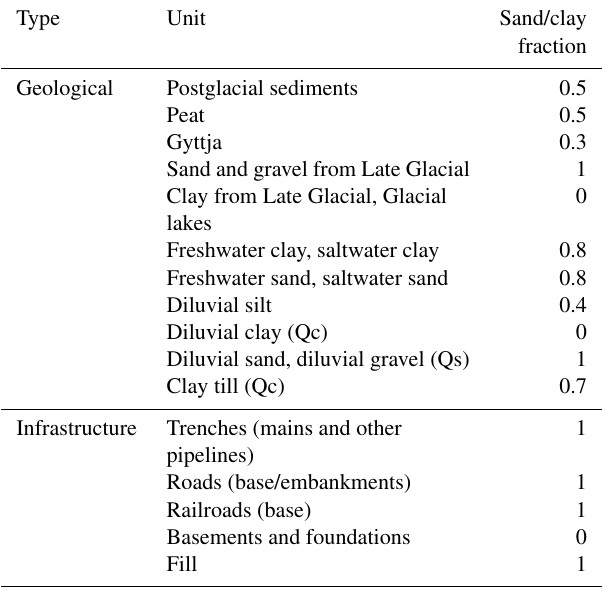
Table 2. Sand/clay fractions for the different geological units and infrastructure used in the voxel